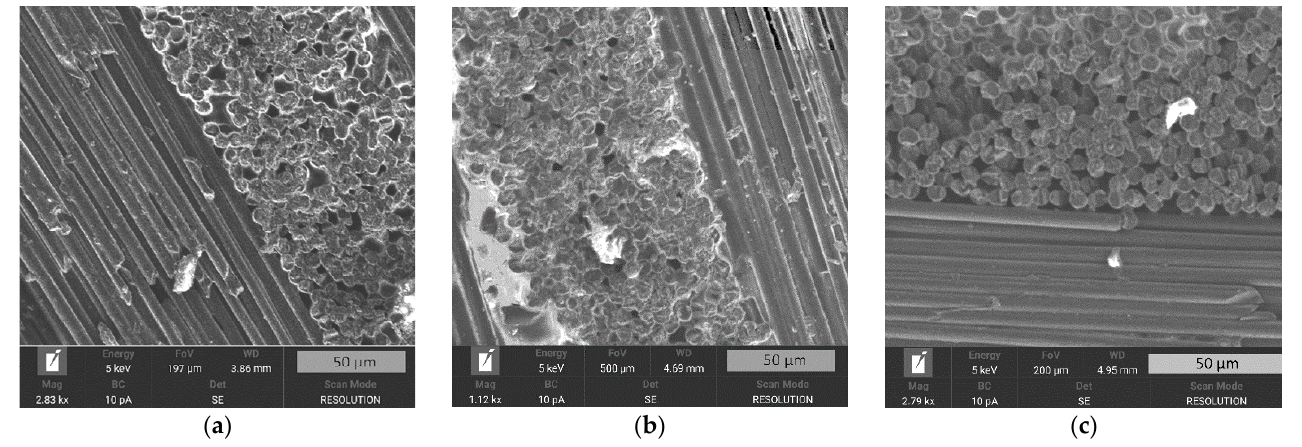
Figure 5. SEM photos of the etched surfaces of composite materials containing ( a ) 50 % wt. ( b ) 60 % wt. and ( c ) 70 % wt. of unmodified carbon fibers.